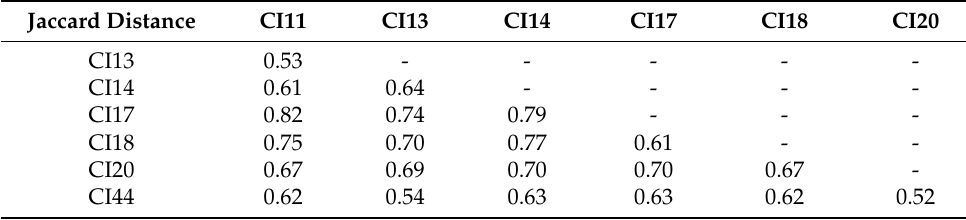
Table 5. The measure of the beta-diversity as indicated by the Jaccard